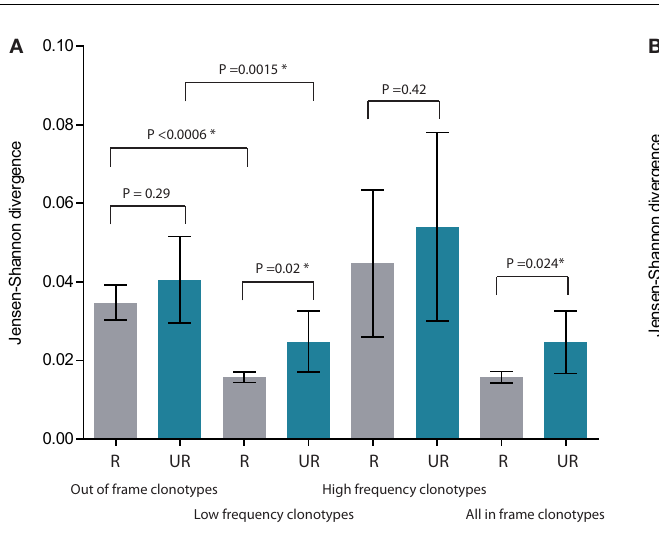
frequencies at the level of sequencing reads, i.e., considering relative abundance of clonotypes in peripheral blood.The lower the Jensen–Shannon divergence, the more similar theTRBV gene segment usage. *Denotes statistical significance. See Figure 1 for delineation of low- and high-frequency clonotypes. Please note that “All in-frame clonotypes” include not only low-frequency and high-frequency clonotypes, but also the medium-frequency